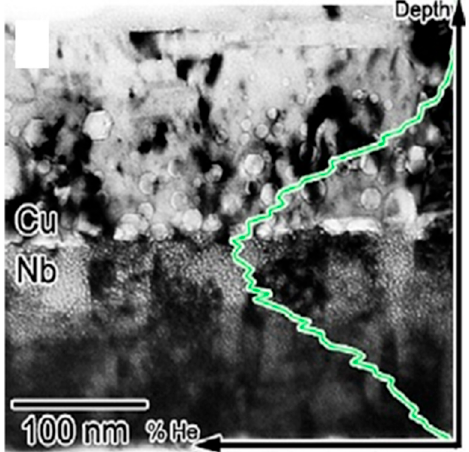
Figure 21. He bubbles in a Cu–Nb composite with h = 120 nm. The Nb layer ( bottom ) contains finely dispersed bubbles with diameter of 1–2 nm. The Cu layer ( top ) contains fewer, but larger He bubbles with a broad size distribution [21].